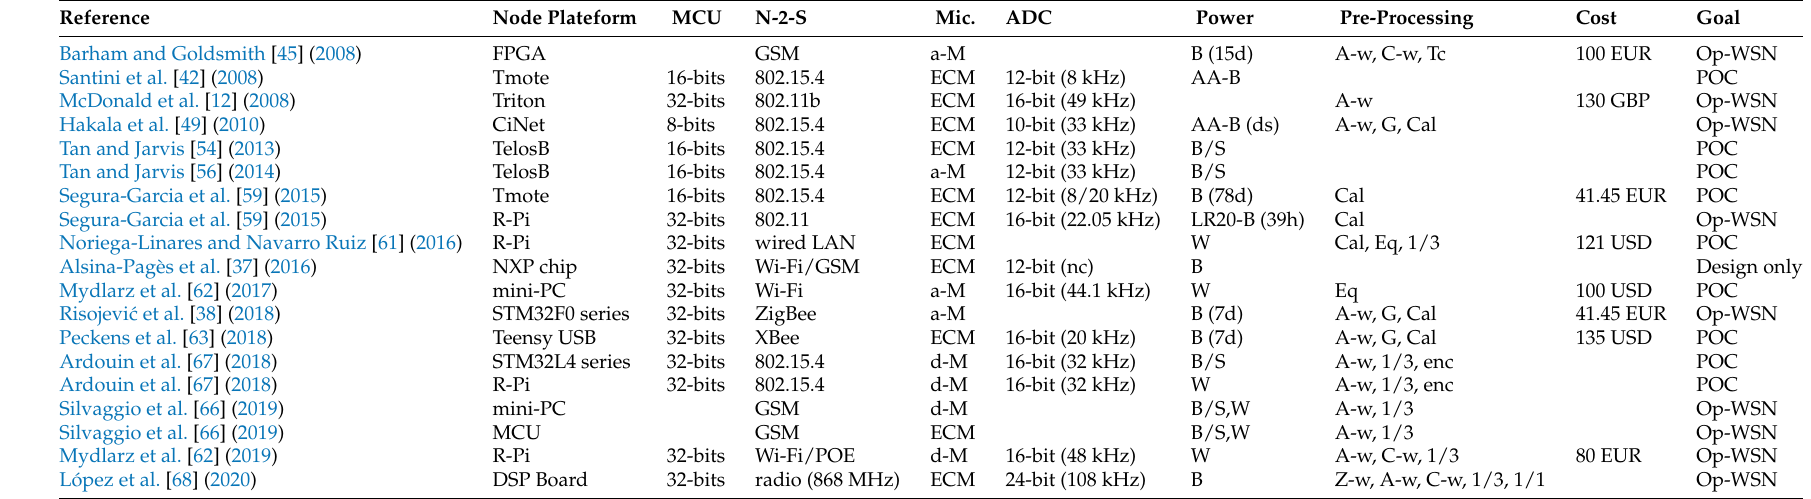
Table 1. Main characteristics of low-cost noise sensors detailed in the literature: node based development platform, quantization level of the MCU, ’N-2-S’ node-to-sink data transmission protocol, ’Mic’ microphone type (ECM, analog MEMS (a-M), digital MEMS (d-M)), ADC quantization and sample frequency, power supply (battery (B), AA and LR20 cells (AA-B or LR20-B), battery with solar panel (B/S), wired connection (W) and energy autonomy in parenthesis when concerned and available (in days or hours)), pre-processing (Z, A or C weighting (Z-w, A-w or C-w), gain amplification (G), calibration (Cal), frequency equalization (Eq), 1/3 or 1/1